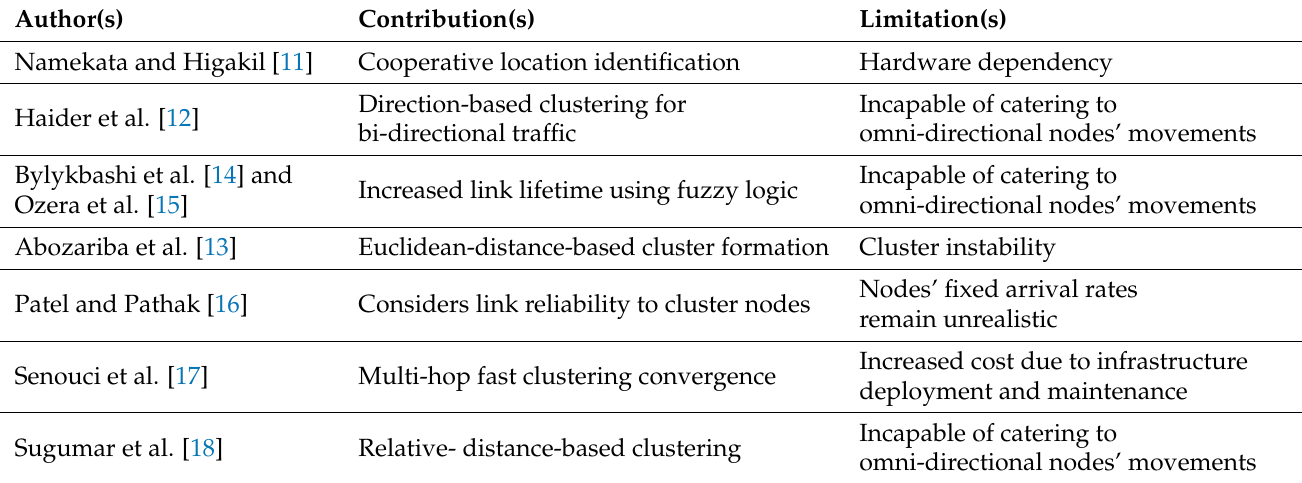
Table 1. Analysis of eminent AMC formation